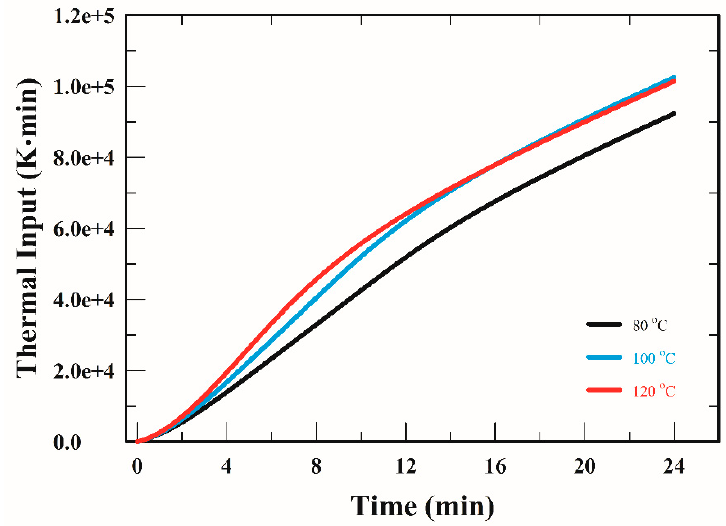
Figure 7. Simulated thermal input of heating germ in the FBD at different set temperature. 80 °C (black line), 100 °C (blue line) and 120 °C (red line).